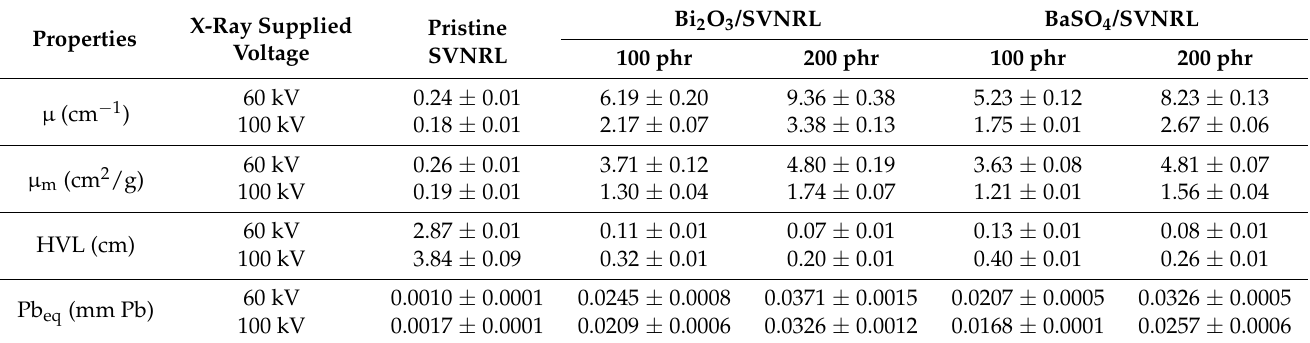
Table 3. Linear attenuation coefficients ( µ ), mass attenuation coefficients ( µ m ), half value layer (HVL), and lead equivalence (Pb eq ) of pristine SVNRL, nano-Bi 2 O 3 /SVNRL, and nano-BaSO 4